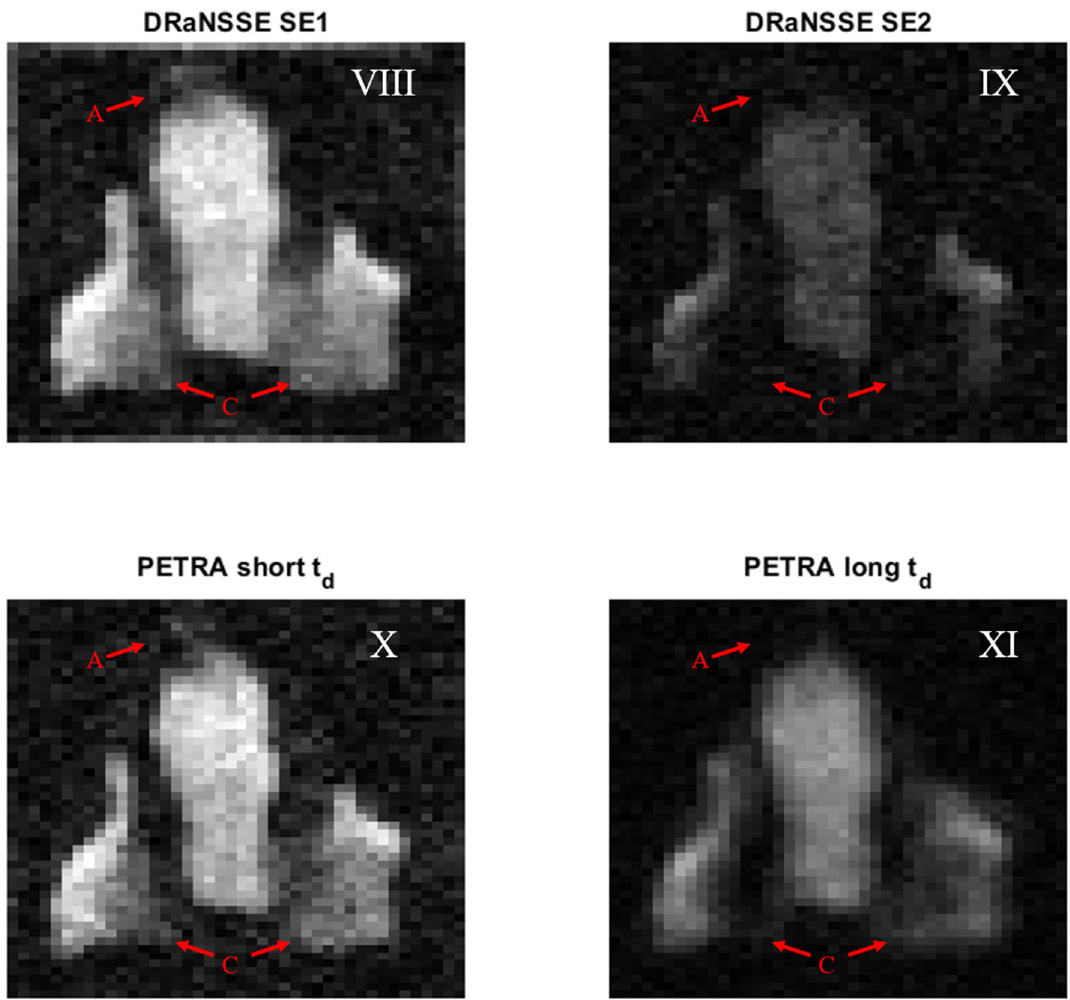
Figure 5. Rabbit image slices obtained with DRaNSSE (top) and PETRA (bottom) for short time parameters (left) and long time parameters